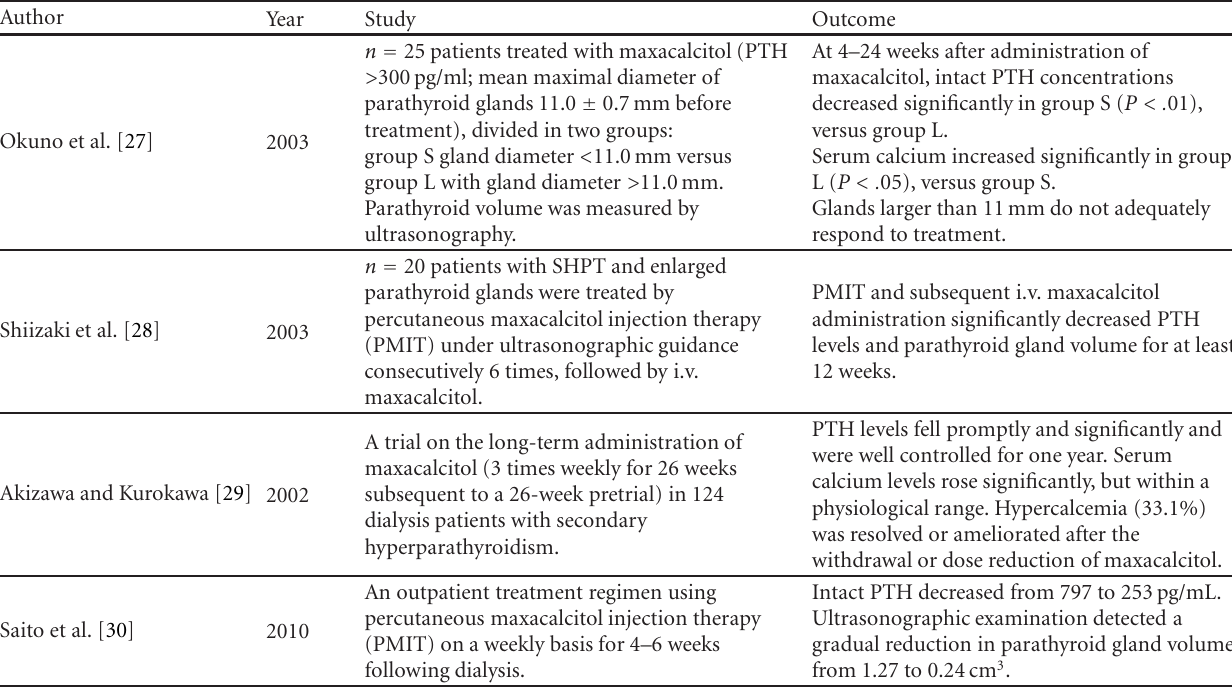
Table 5: Parathyroid hyperplasia.